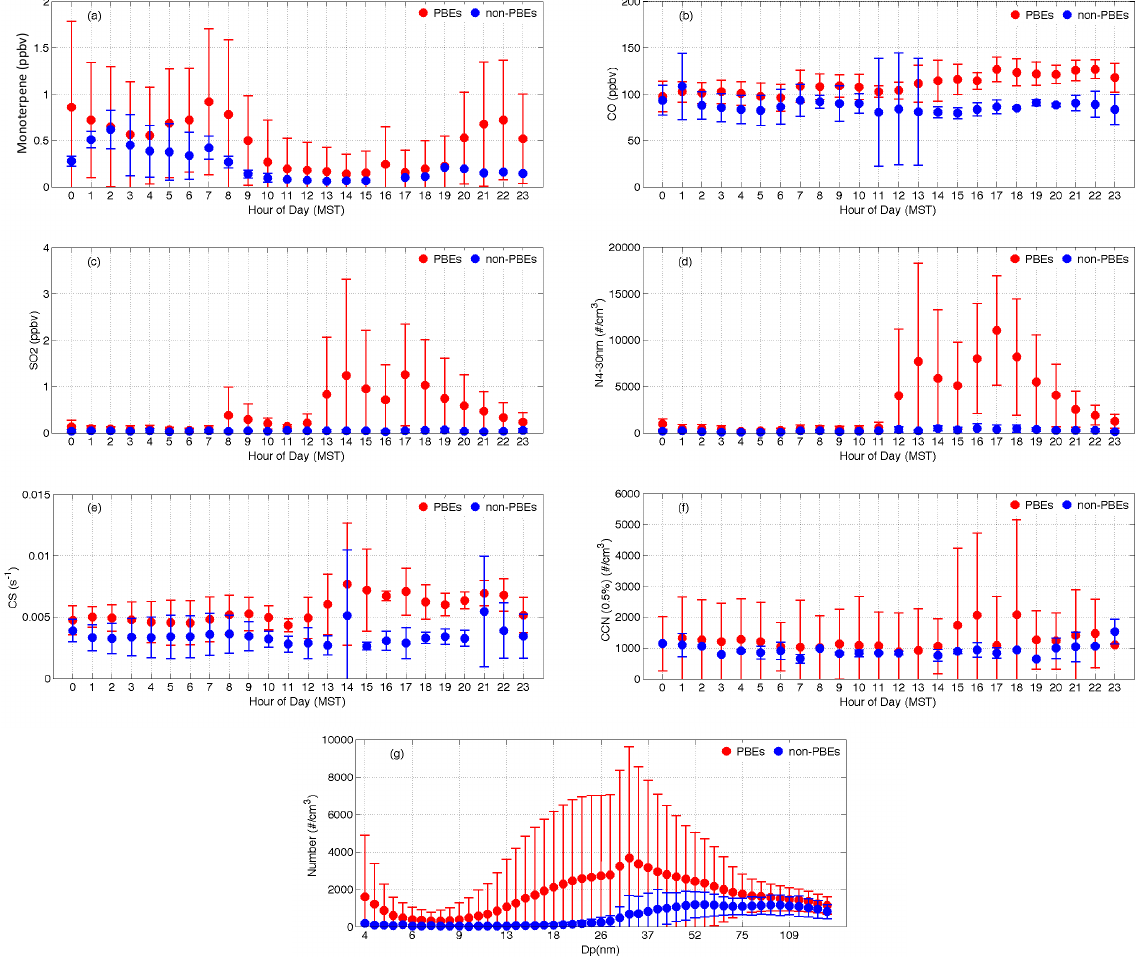
Figure 4. Comparison of measured parameters at the MEFO site during PBE and non-PBE days including hourly averaged diurnal profiles of (a) monoterpenes, (b) CO, (c) SO 2 , (d) number concentrations of 4–30nm diameter particles, (e) condensation sinks (CS, s − 1 ) , (f) CCN concentrations at 0.5% supersaturation, and (g) number size distribution (from 4.4 to 150nm). Error bars indicate 1 σ variability.